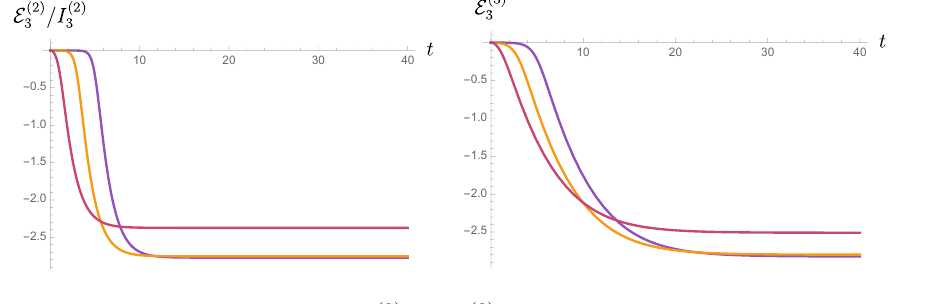
and I (3) for the compacti(cid:12)ed boson (3.25) with (cid:17) = 2, 3 3